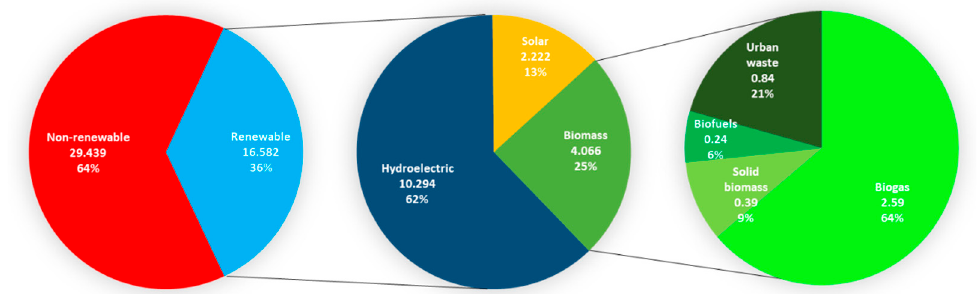
Figure 6. Provenience of the electrical energy produced in Lombardy in 2018 (in